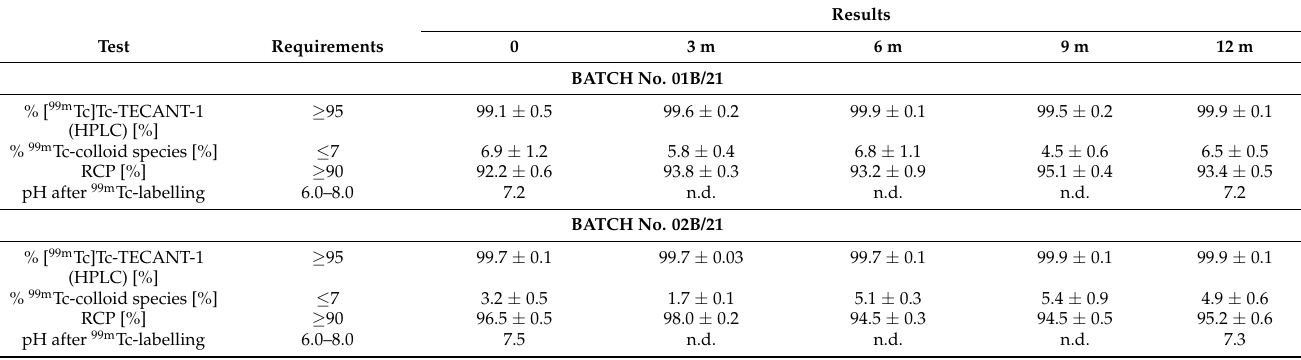
Table 7. Summary of radiolabelling of batches 01B/21 and 02B/21 after different storage